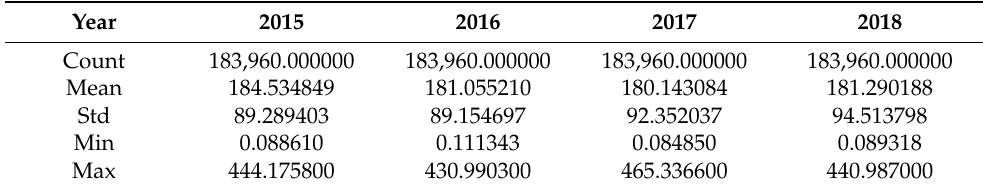
Table 3. Descriptive statistics of solar radiation data considered.